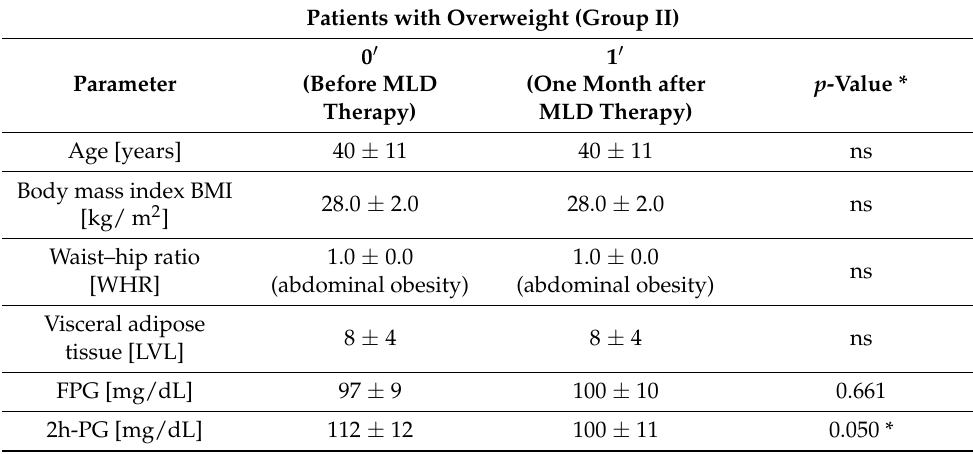
Table 4. Biochemical parameters before (0 (cid:48) ) and one month after (1 (cid:48) ) MLD therapy in a patients with overweight (group